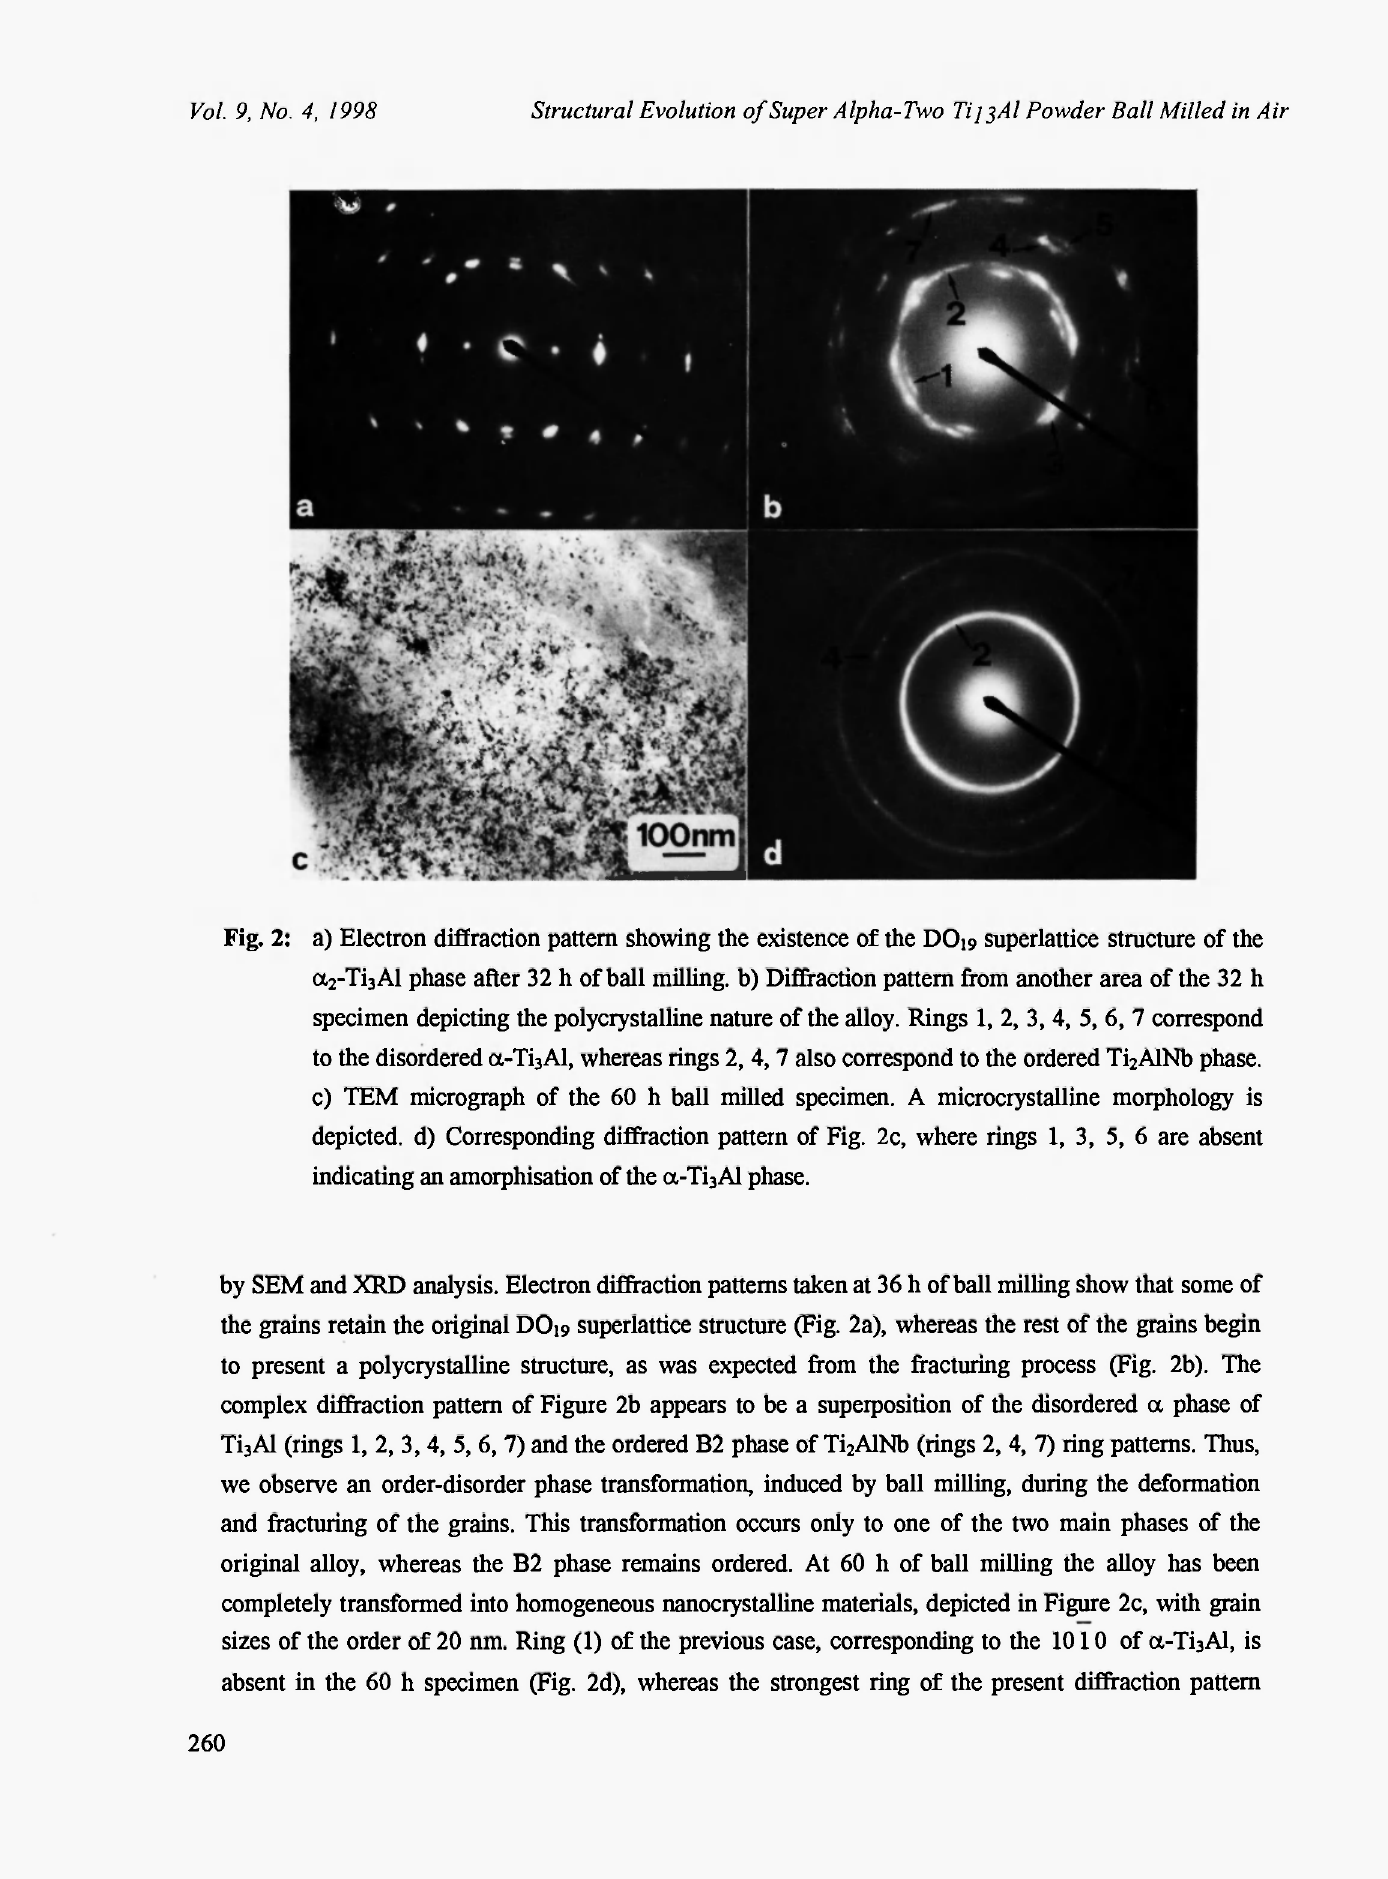
Fig. 2: a) Electron diffraction pattern showing the existence of the DO19 superlattice structure of the a -Ti Al phase after 32 h of ball milling, b) Diffraction pattern from another area of the 32 h 2 3 specimen depicting the polycrystalline nature of the alloy. Rings 1, 2, 3, 4, 5, 6, 7 correspond to the disordered a-Ti Al, whereas rings 2, 4, 7 also correspond to the ordered Ti 3 c) TEM micrograph of the 60 h ball milled specimen. A microcrystalline morphology is depicted, d) Corresponding diffraction pattern of Fig. 2c, where rings 1, 3, 5, 6 are absent indicating an amorphisation of the a-Ti Al 3